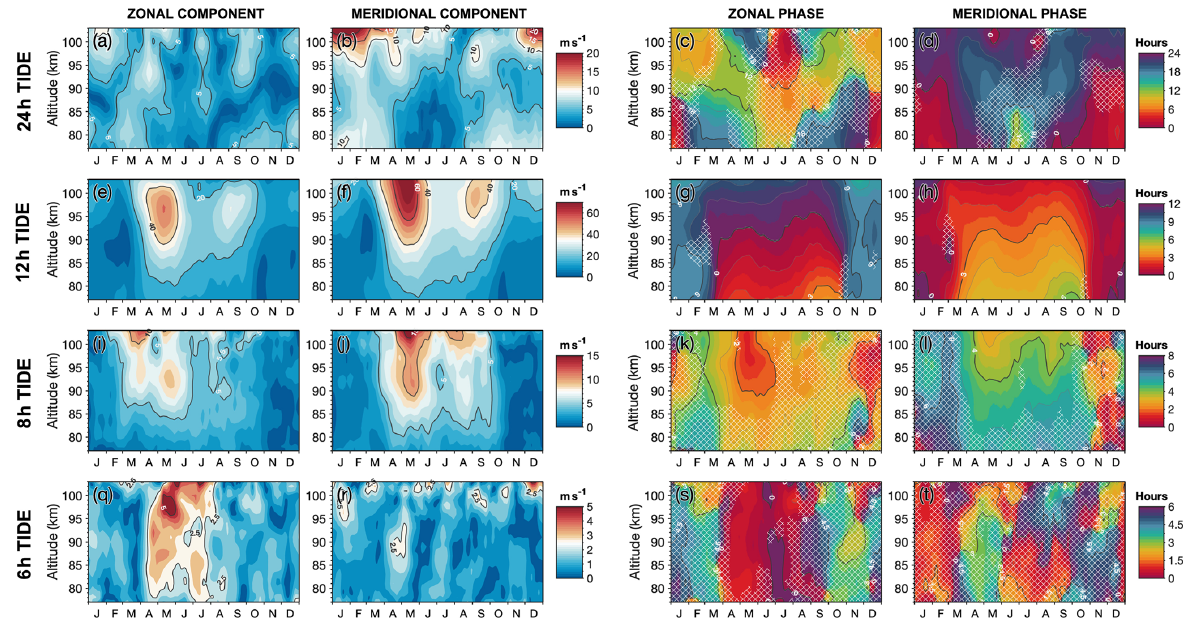
Figure 5. Zonal and meridional wind amplitudes and phases of the diurnal (24h), semidiurnal (12h), terdiurnal (8h), and quardiurnal (6h) solar tides in the MLT over South Georgia averaged for the years 2016 to 2020. Tidal amplitudes and phases are fitted to composite daily winds derived using a sliding 30d time window of measurements. Phases are given in hours since midnight local time. Hatched regions show where the measured tidal amplitudes are low (less than 5ms − 1 for the 24, 12, and 8h tides, and less than 2.5ms − 1 for the 6h tide) and phase measurements may less